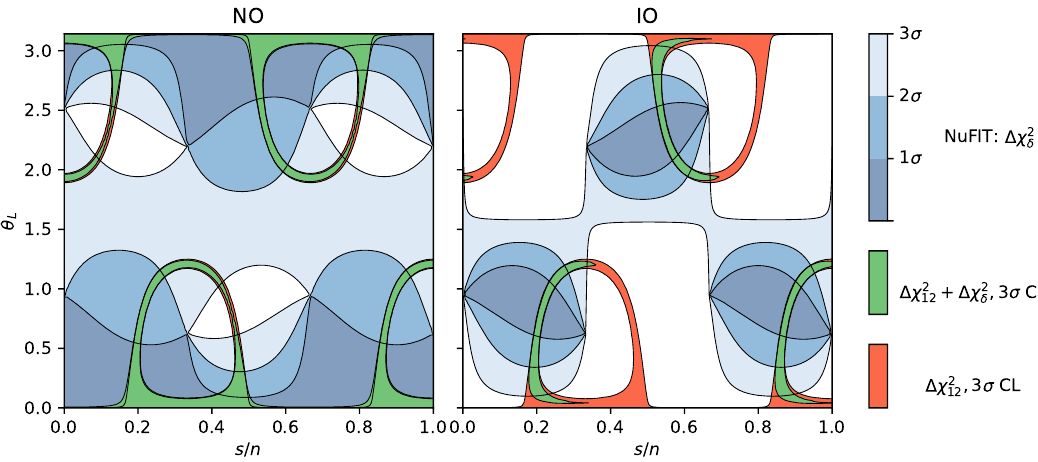
Figure 2 . Case 3 a) Impact of constraints on the value of the CP phase δ for light neutrino masses with NO (left plot) and IO (right plot), respectively. We show the areas, leading to an agreement with the global fit data on the solar mixing angle θ and CP phase δ at the 3 σ level or better, in 12 the s/n − θ -plane. The conventions and colour coding are the same as in figure 1. The impact of L imposing constraints on the CP phase δ is only very mild for light neutrino masses with NO, while adding information on the value of δ considerably affects the allowed areas in the s/n − θ -plane in L the case of